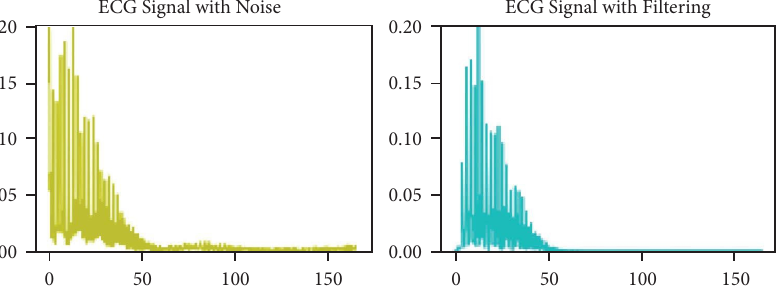
Figure 9: Filtering ECG